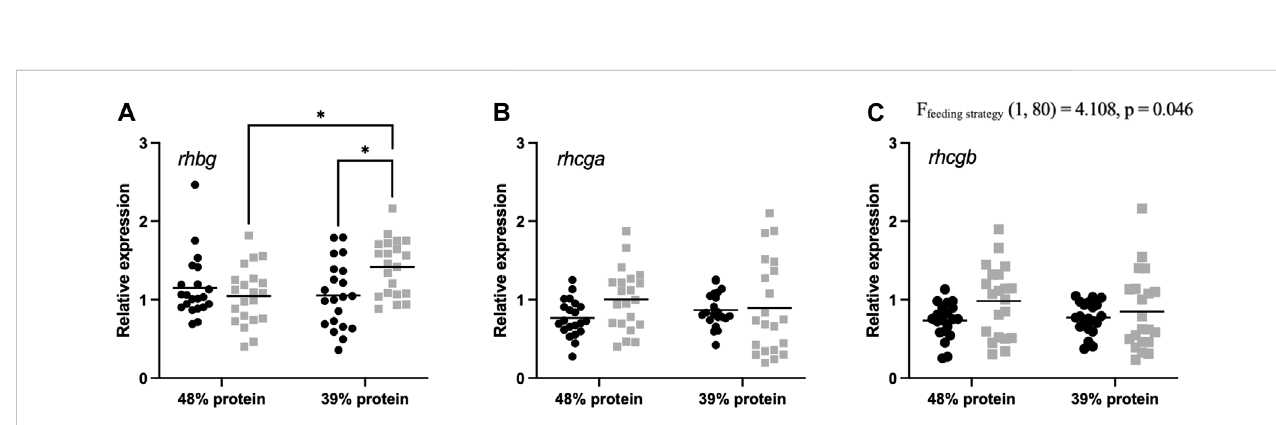
FIGURE 5 Rhesus glycoprotein transporter relative gene expression in gills of demand-fed and batch-fed carp fed 48% or 39% protein diets. Relative expression in demand-fed and batch-fed carp gills of (A) Rhesus glycoprotein B (rhbg), (B) Rhesus glycoprotein C type A (rhcg-a), and (C) Rhesus glycoprotein C type B (rhcg-b). Gene expression is shown as expression relative to β -actin and RPS11 expression. Gene expression was measured in 21 animals per group ( n = 21). (cid:129) ),batch-fedindividualsasgreysquares( ■ ).Eachdot representsoneanimal,horizontalbarsindicate Demand-fedindividuals areshownas blackcircles( meanrelativeexpression.Signi fi cancewas testedwith atwo-way ANOVA withthefactors ‘ Feeding strategy ’ and ‘ Dietary proteinlevel ’ .Feeding strategyhada signi fi cant effect on rhcg-b expression ( p = 0.046). In case of signi fi cant interaction effects (rhbg), a Tukey multiple comparisons post hoc test was used. Asterisks indicate signi fi cant differences between groups based on post hoc tests, * p <